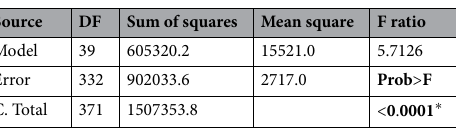
Table 2. Analysis of Variance. Significance values are in bold.